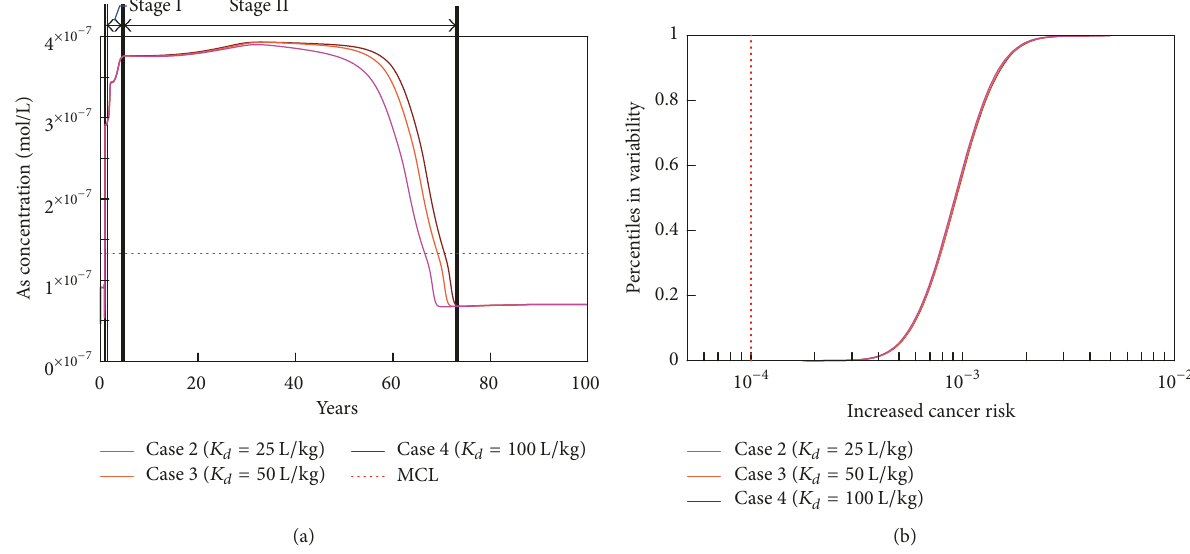
Figure 10: (a) ∑ As profiles with different 𝐾 𝑑 of 25, 50, and 100 L/kg −1 (Cases 2–4) and (b) probabilistic health risk plotted as cumulative density functions. The red dotted line represents the risk level of concern (10 −4